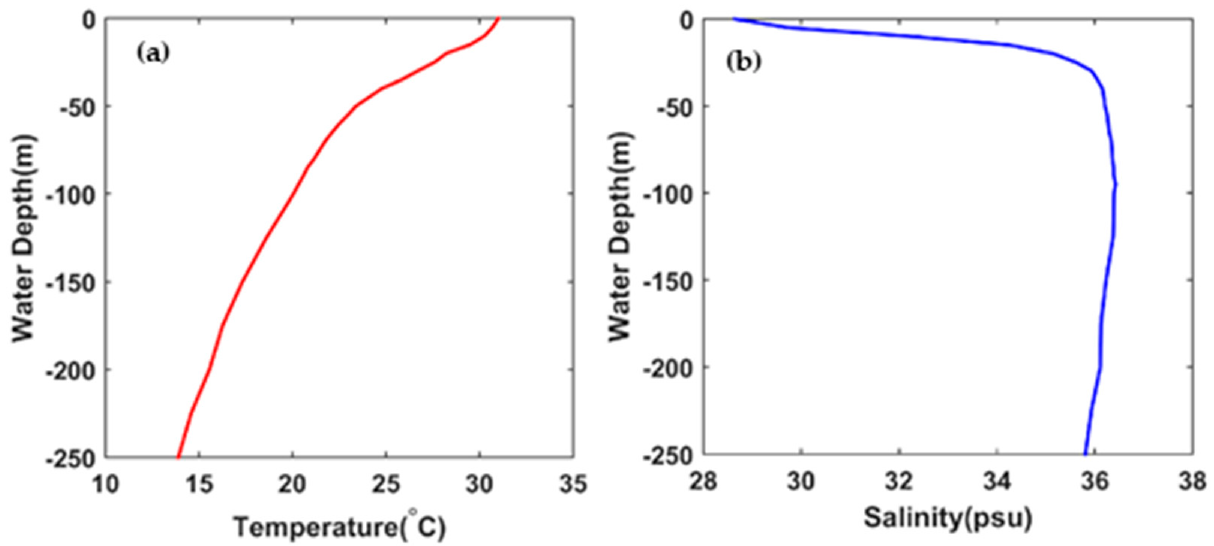
Figure 3. Temperature ( a ) and salinity ( b ) profiles from the WOA database for September at a location on the Louisiana shelf off Terrebonne Bay.